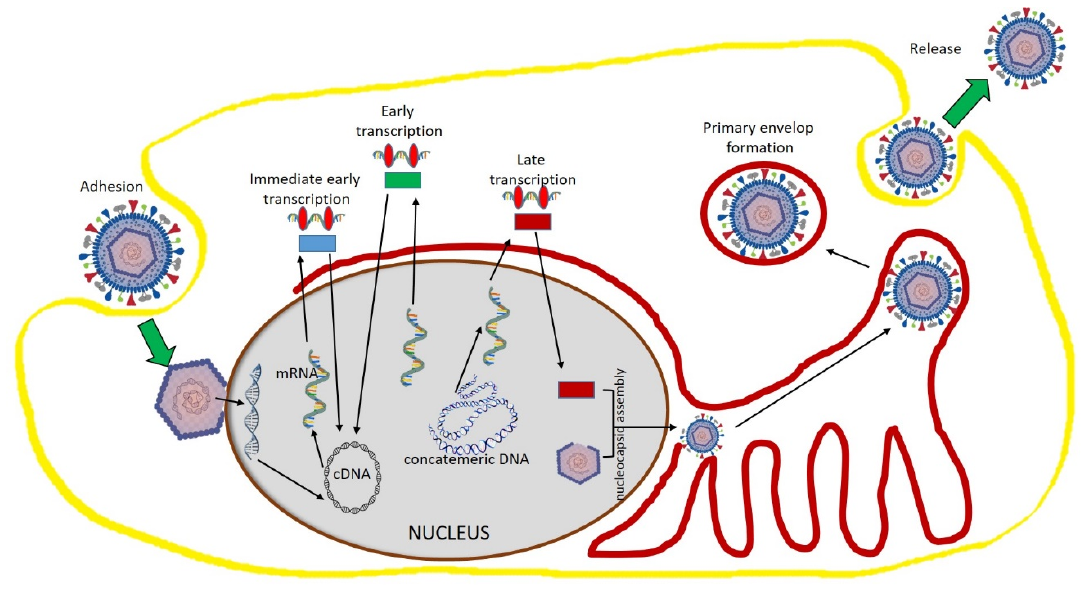
Figure 2. Herpes simplex virus structure and replication mechanism. The HSV structure in this figure has been modified from the source https://pnghut.com.